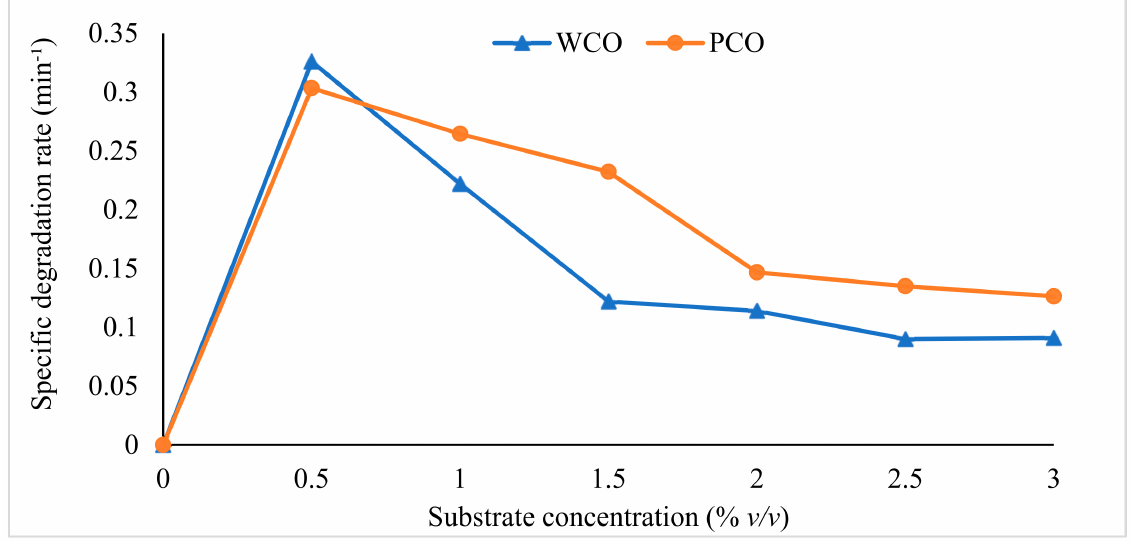
Figure 2. Specific degradation rates of WCO and PCO with increasing initial substrate